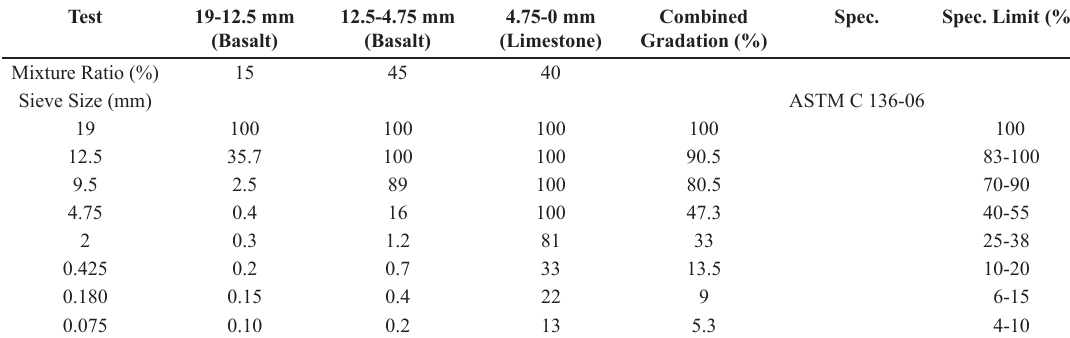
Table 3. Gradation for basalt – limestone aggregate mixture.